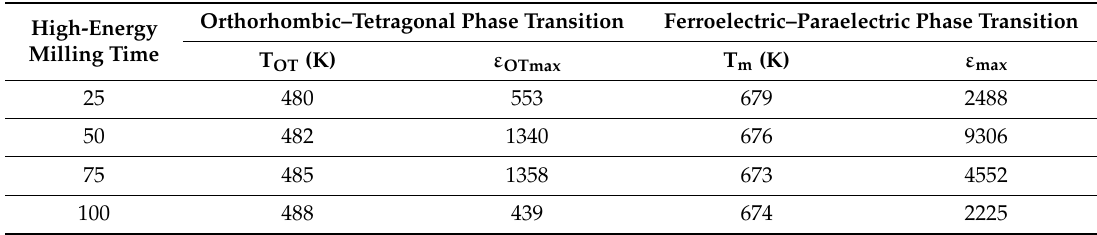
Table 2. Value of dielectric permittivity in phase transitions and temperatures of phase transitions.